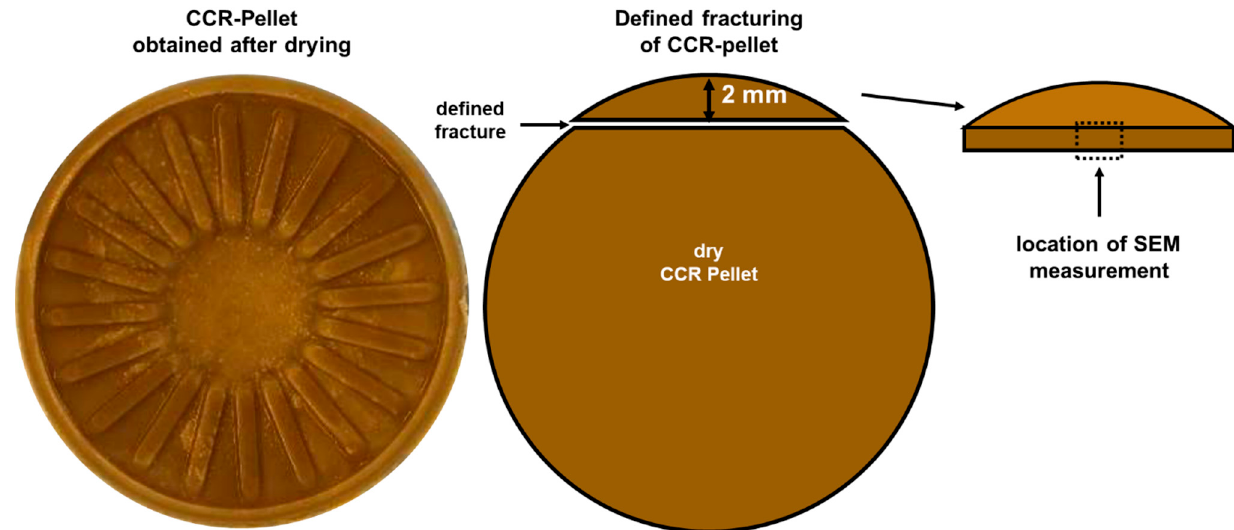
Figure 2. Sketch of the process of preparing the CCR-pellets for SEM measurements.